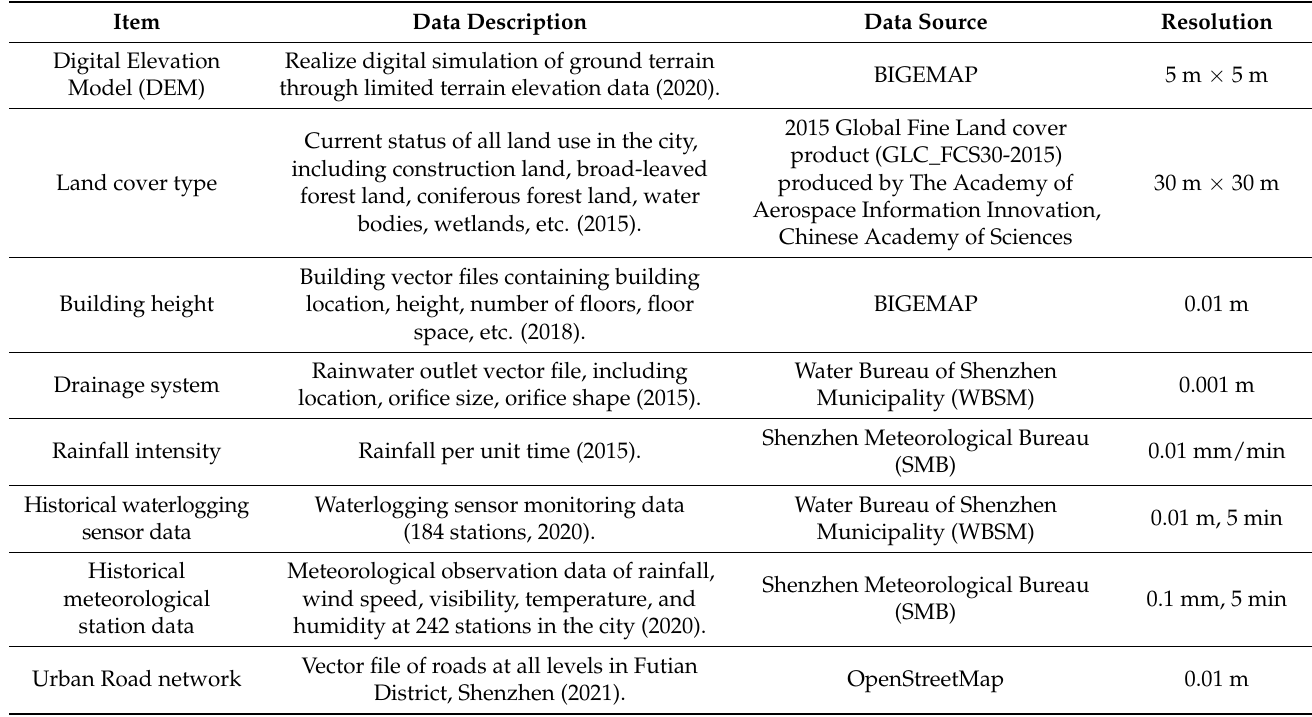
location, height, number of floors, floor space, etc.